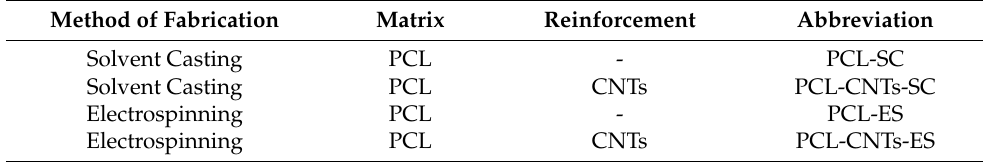
Table 1. Fabricated scaffolds, employed materials, and abbreviations. Method of Fabrication Matrix Reinforcement Abbreviation Solvent Casting PCL - PCL-SC Solvent Casting PCL CNTs PCL-CNTs-SC Electrospinning PCL - PCL-ES Electrospinning PCL CNTs